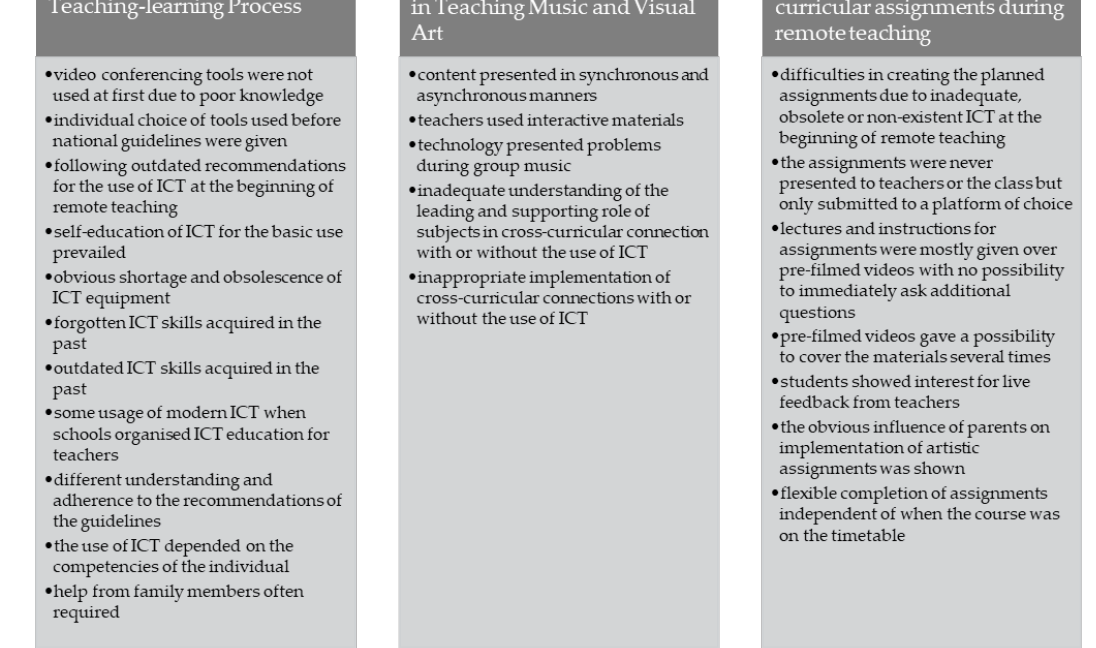
Figure 8. The main findings summarised and divided based on the research questions.